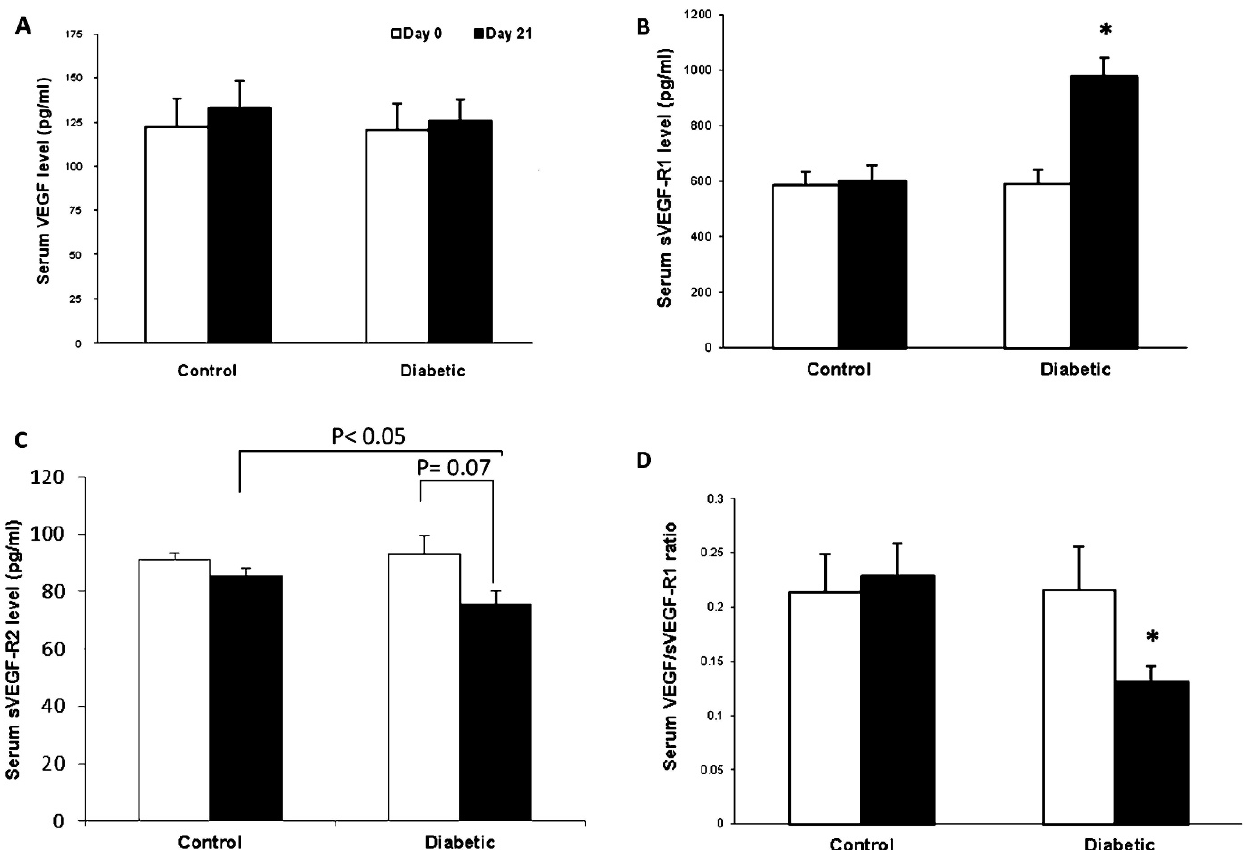
Figure 2 - The serum VEGF (A), sVEGF-R1 (B), and sVEGF-R2 concentrations (C) and the VEGF:VEGF-R1 ratio (D) before (white column) and after (black column) the induction of diabetes. * p , 0.05 compared to